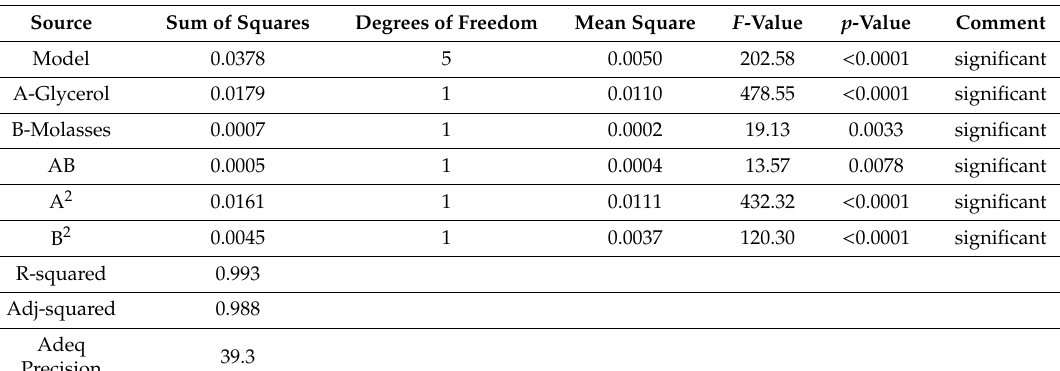
Table 3. ANOVA table of model for relative carbon yield.